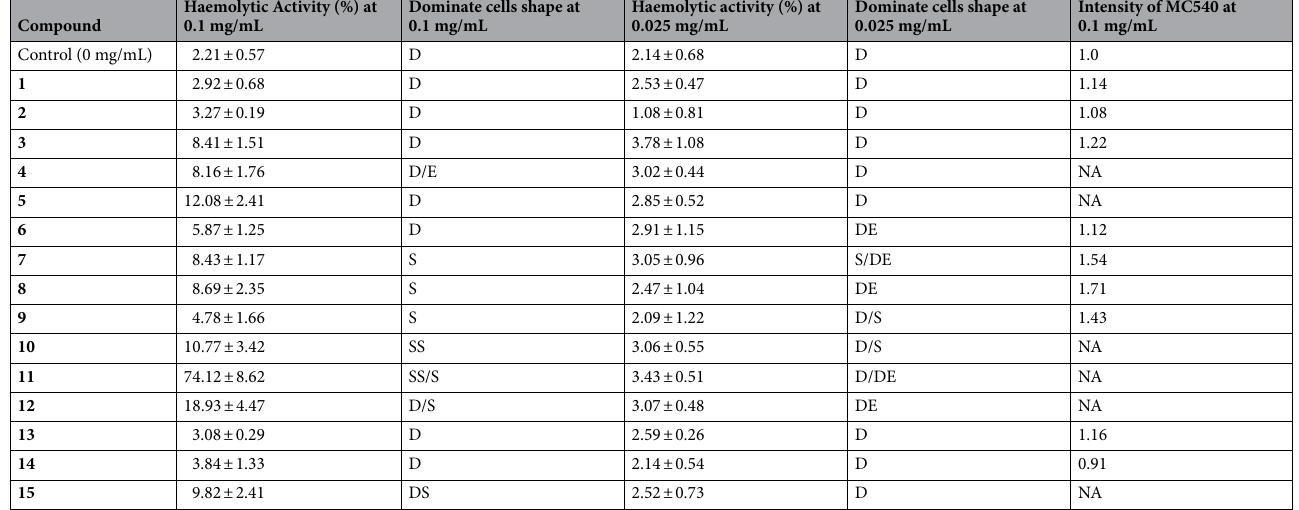
Table 1. The haemolytic activity of compounds studied and the predominated human RBC shape after the standard incubation with compounds (1 h, 37° C). The predominant human RBC shape: D-biconcave- discocytes, control cells, DE-discoechinocytes; E-echinocytes; S-stomatocytes; SS-spherostomatocytes. Haemolytic activity > 5% means the significant membrane-perturbing activity of a compound. NA not analyzed because of haemolysis. Data represent the mean value ± SD from 3 independent experiments (n =